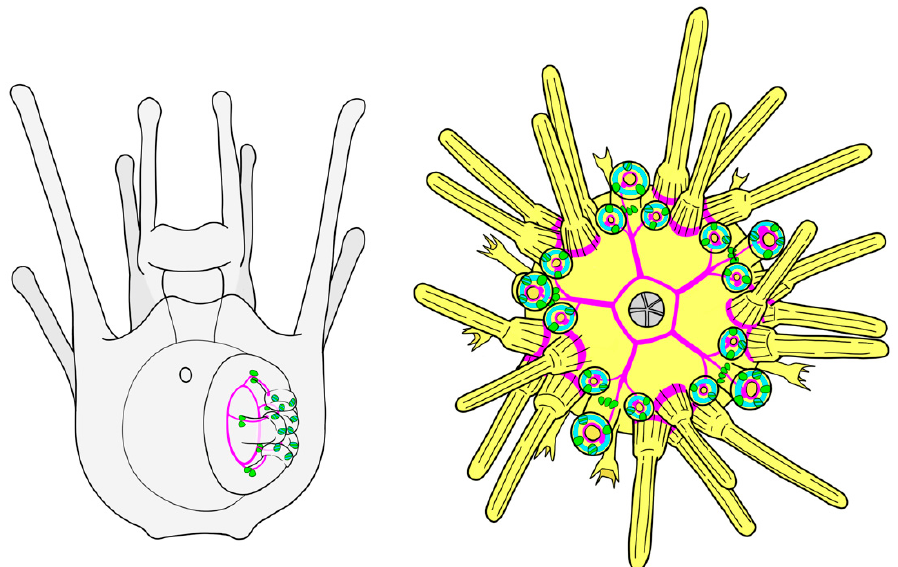
Figure 7. Schemes with the opsin expression on them and the molecular signature of the 2 clusters of PRC identified at mature rudiment stage. Nervous system in magenta, Opsin4+ PRCs in green, opsin2+ PRCs in cyan, Opsin1+PRCs in yellow.